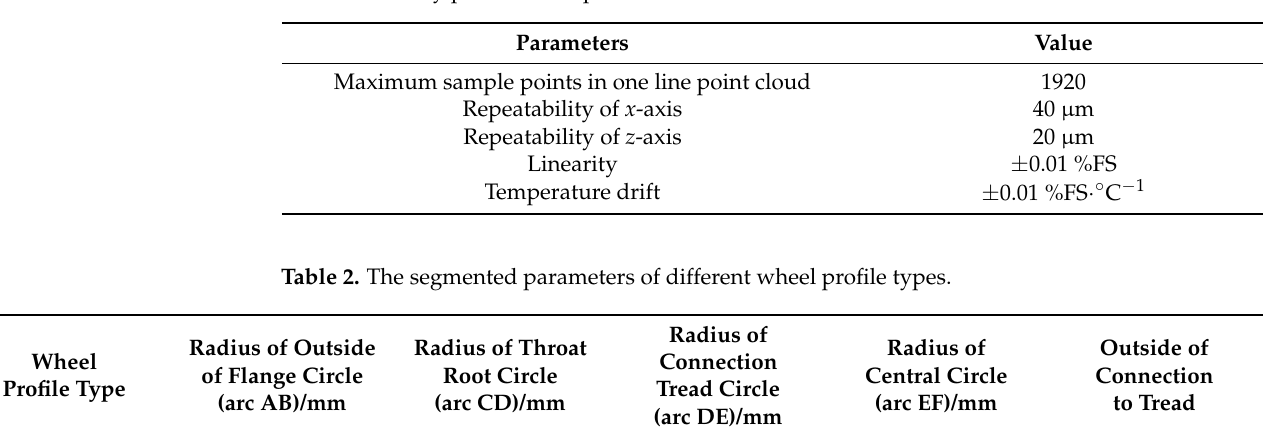
Figure 6. Using laser profile sensor to scan the wheel profile. Table 1. The key performance parameters of the laser sensor.